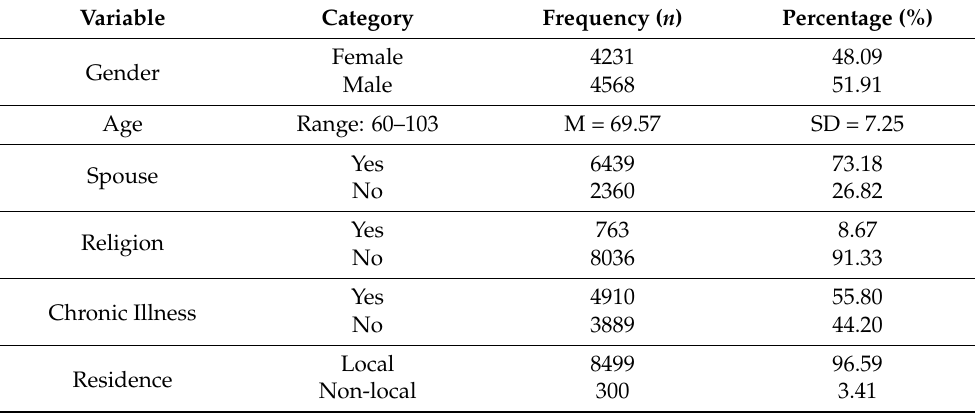
Table 1. Demographic characteristics of participants ( n =